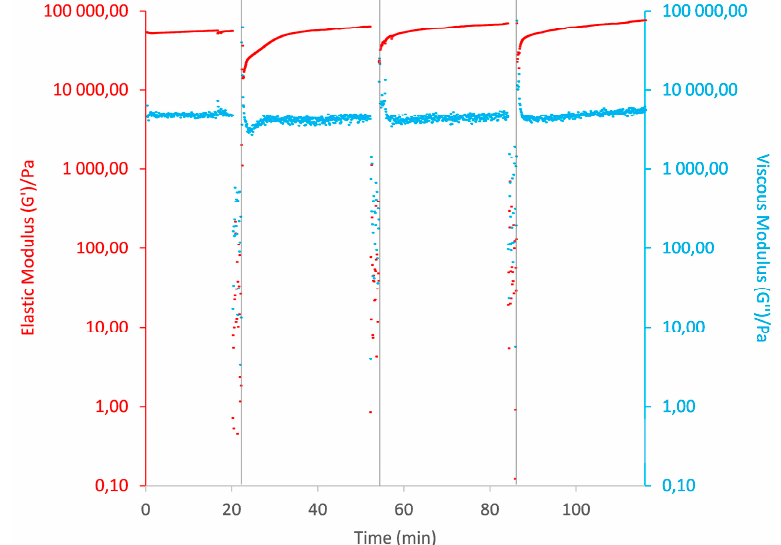
Figure 3. Step-strain measurement of 4% ( w / v ) hydrogel at fixed angular frequency of 1 Hz. The gel was swept from 0.04% to 15% strain and then back to 0.04% strain. This analysis was repeated at least three times for reproducibility